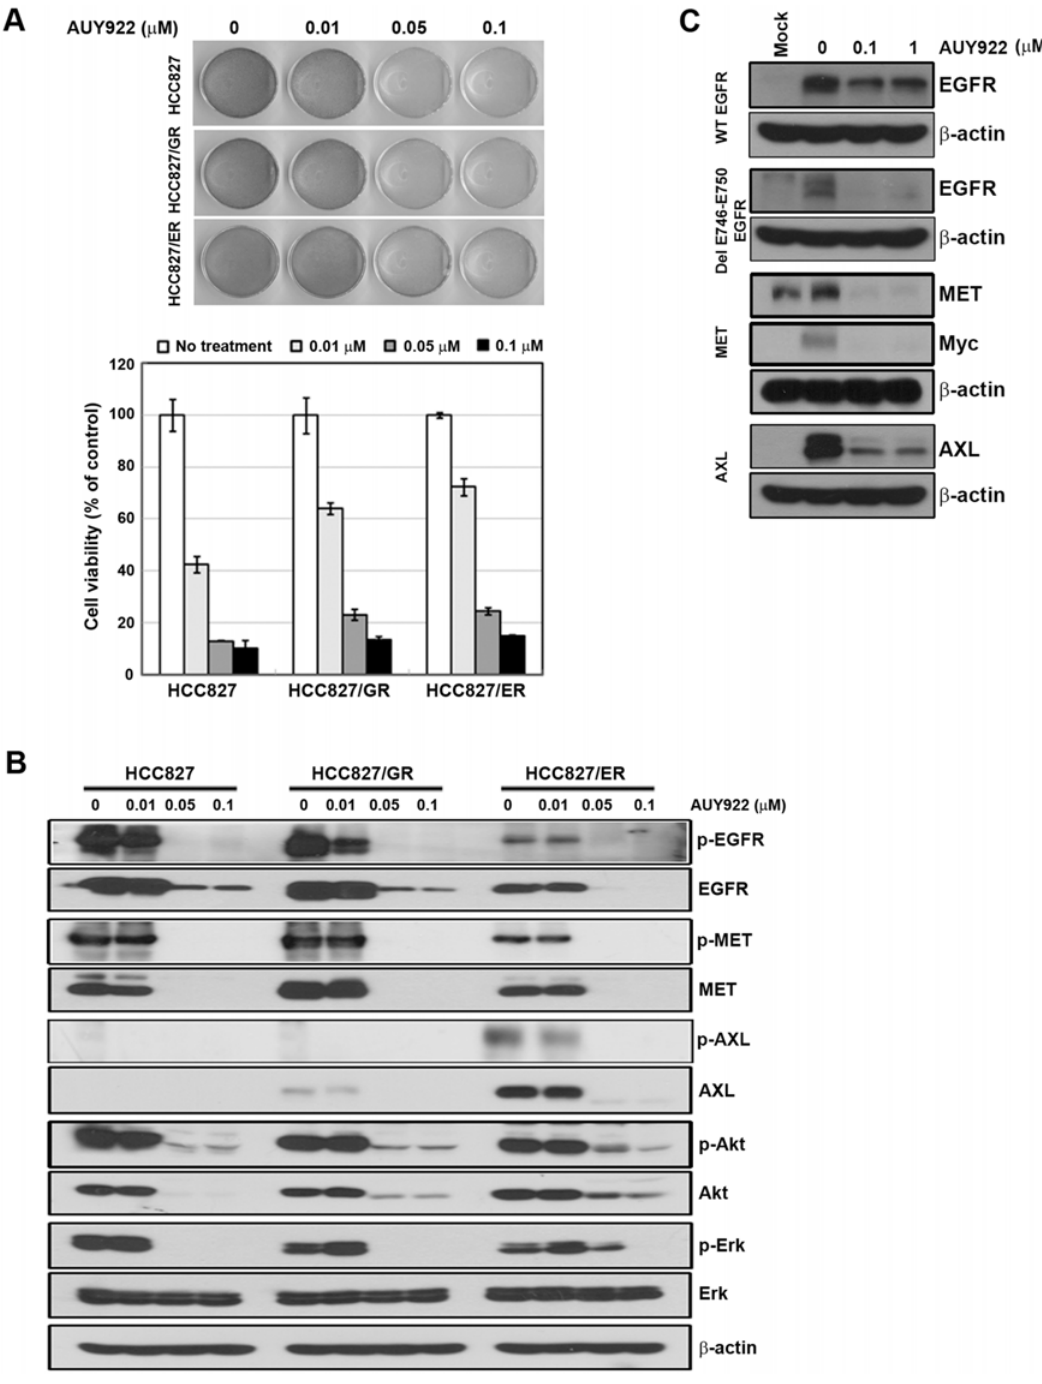
Fig 2. Suppression of MET and AXL by AUY922 in resistant cell lines. A , Cells were treated with the indicated doses of AUY922 for 72 hours in medium containing 1% FBS. Attached cells were stained with trypan blue solution (top). Cell viability based on cell counting is also shown (bottom). Bars represent the mean ± SD of three wells. B , Cells treated with AUY922, similar to panel A. After 48 hours, cells were harvested and EGFR-related signaling molecules were evaluated using western blotting. C , LK2 cells were treated with vector-containing wild-type EGFR, del E746-E750, MET, or AXL and the indicated doses of AUY922 for 12